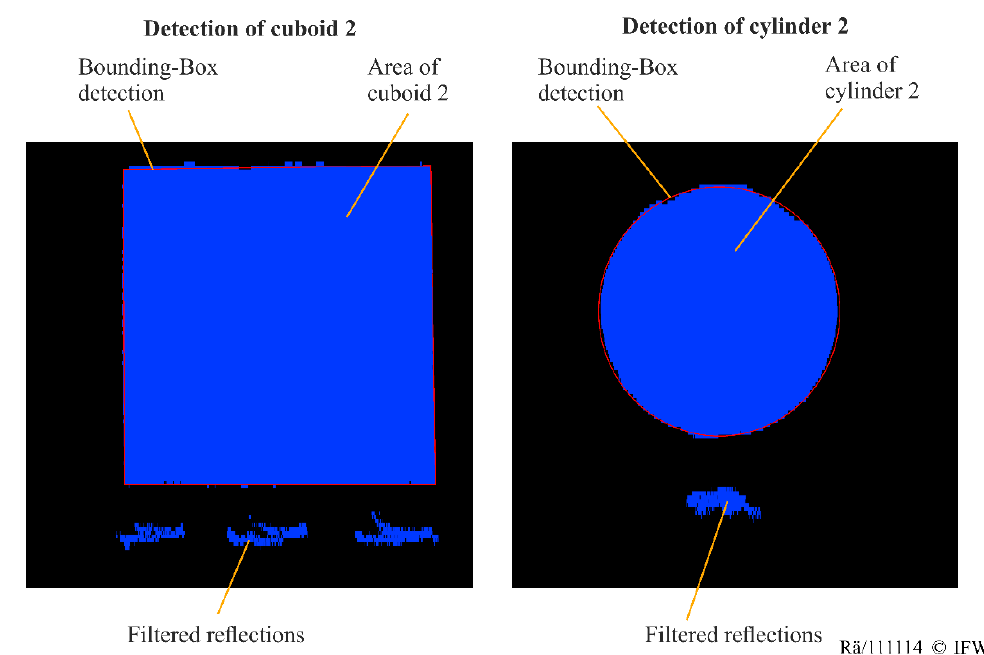
Figure 13. An example of the bounding-box detection in the investigation. The rectangular shape of the cuboid surface and the circular shape of the cylinder were correctly captured by the red bounding box. Following the detection, the x and y dimensions and the locations of the bounding boxes were automatically determined. For